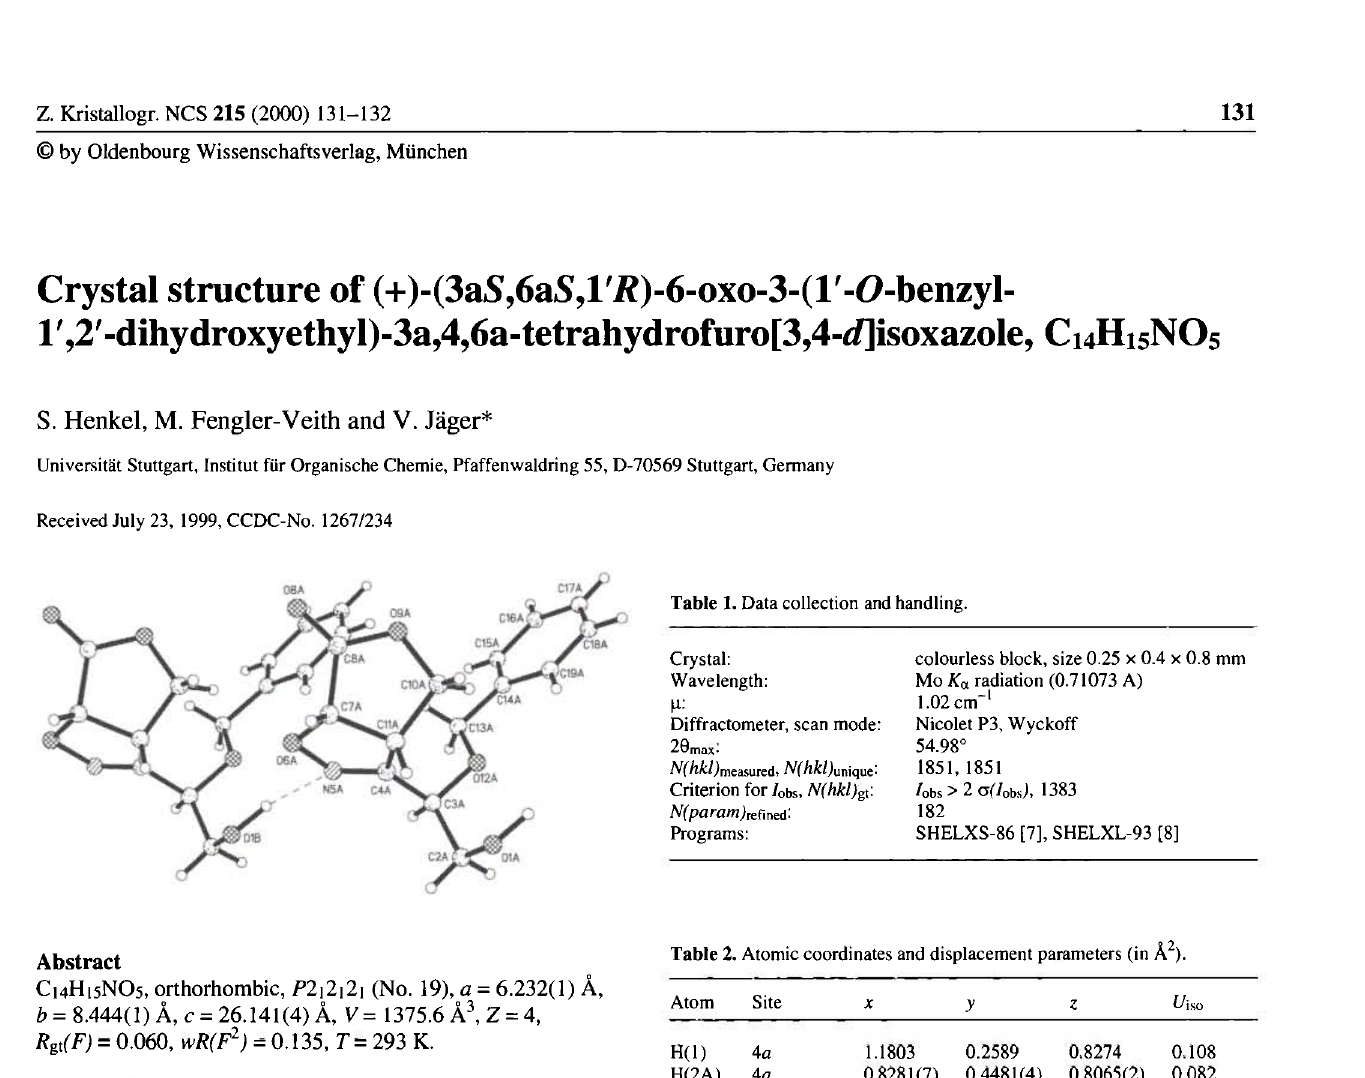
Table 2. Atomic coordinates and displacement parameters (in Ä 2 ).